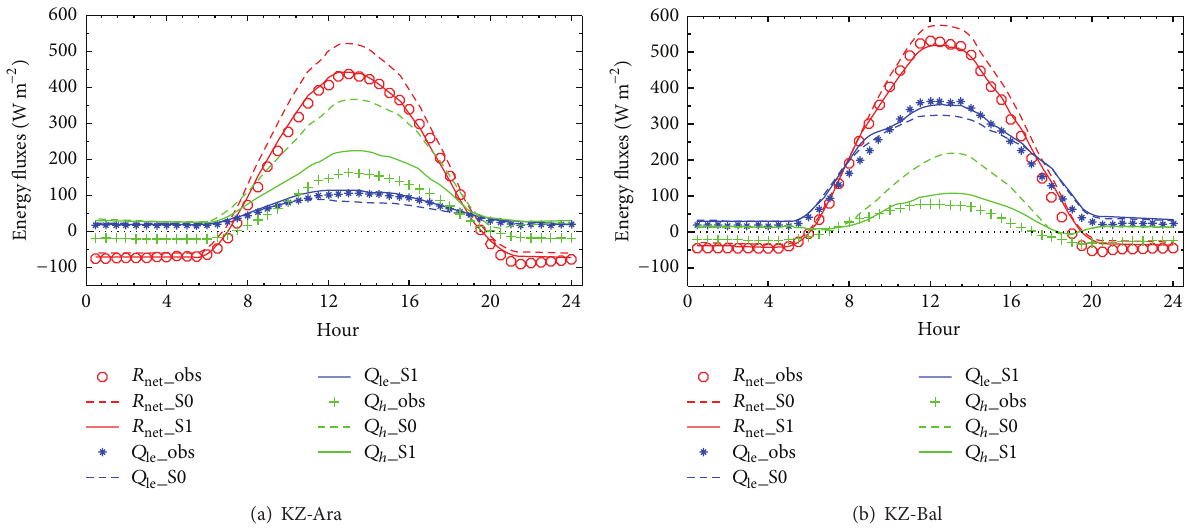
Figure 4: Comparison between the measured net radiation ( 𝑅 net ), latent heat flux ( 𝑄 le ), and sensible heat flux ( 𝑄 ℎ ) and the values simulated by the reference model (S0) and the model with refined roughness length (S1) on a diurnal course at the KZ-Ara and KZ-Bal sites. The diurnal flux values were calculated as the mean values of all data at same measurement time in a day for the entire time